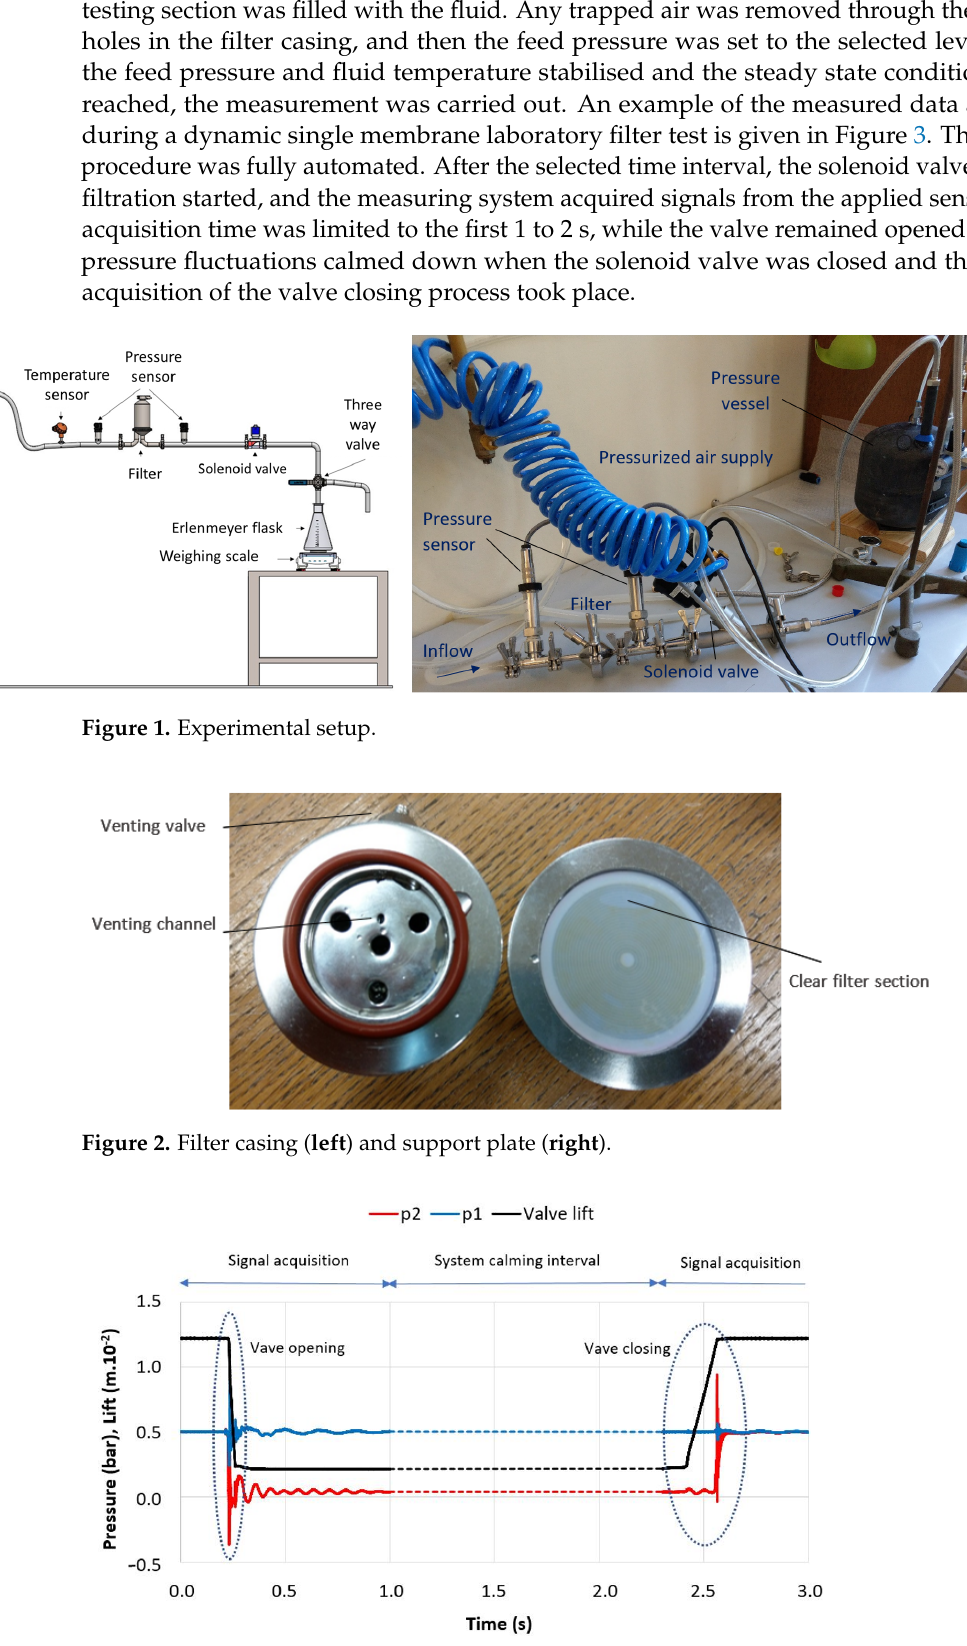
Figure 3. Pressure ahead and behind the filter ( p 1 and p 2 , respectively) and solenoid valve lift variation versus time acquired during single membrane laboratory filter dynamic